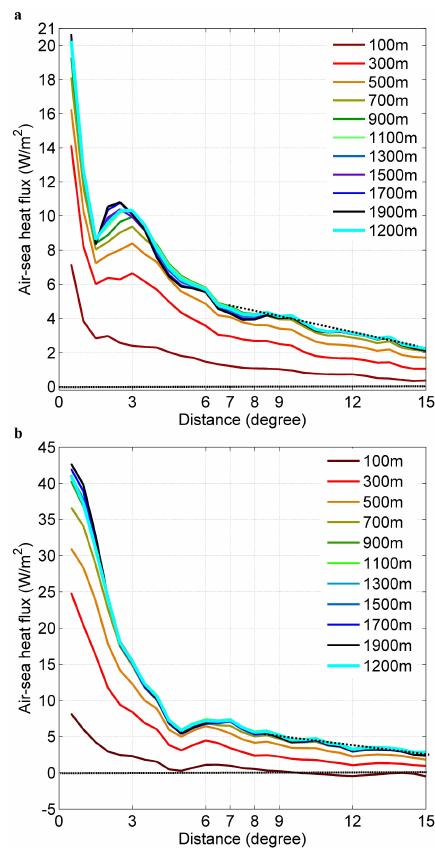
Figure 4. Estimates of air–sea heat flux within TC with different footprint domain sizes (horizontal and depth) for (a) TS/TDs and (b) hurricanes. The results of 1200m are highlighted in